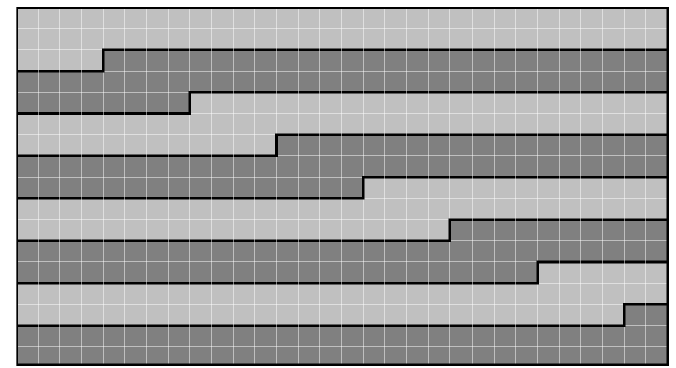
Figure 1. Layout of a Full HD frame with 8 slices (7 slices of 64 CTUs and 1 slice of 62 CTUs).